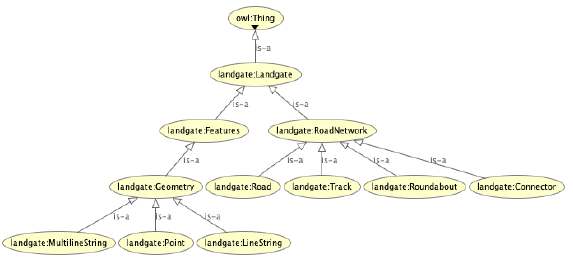
Figure 5. Representation of the Landgate ontology.